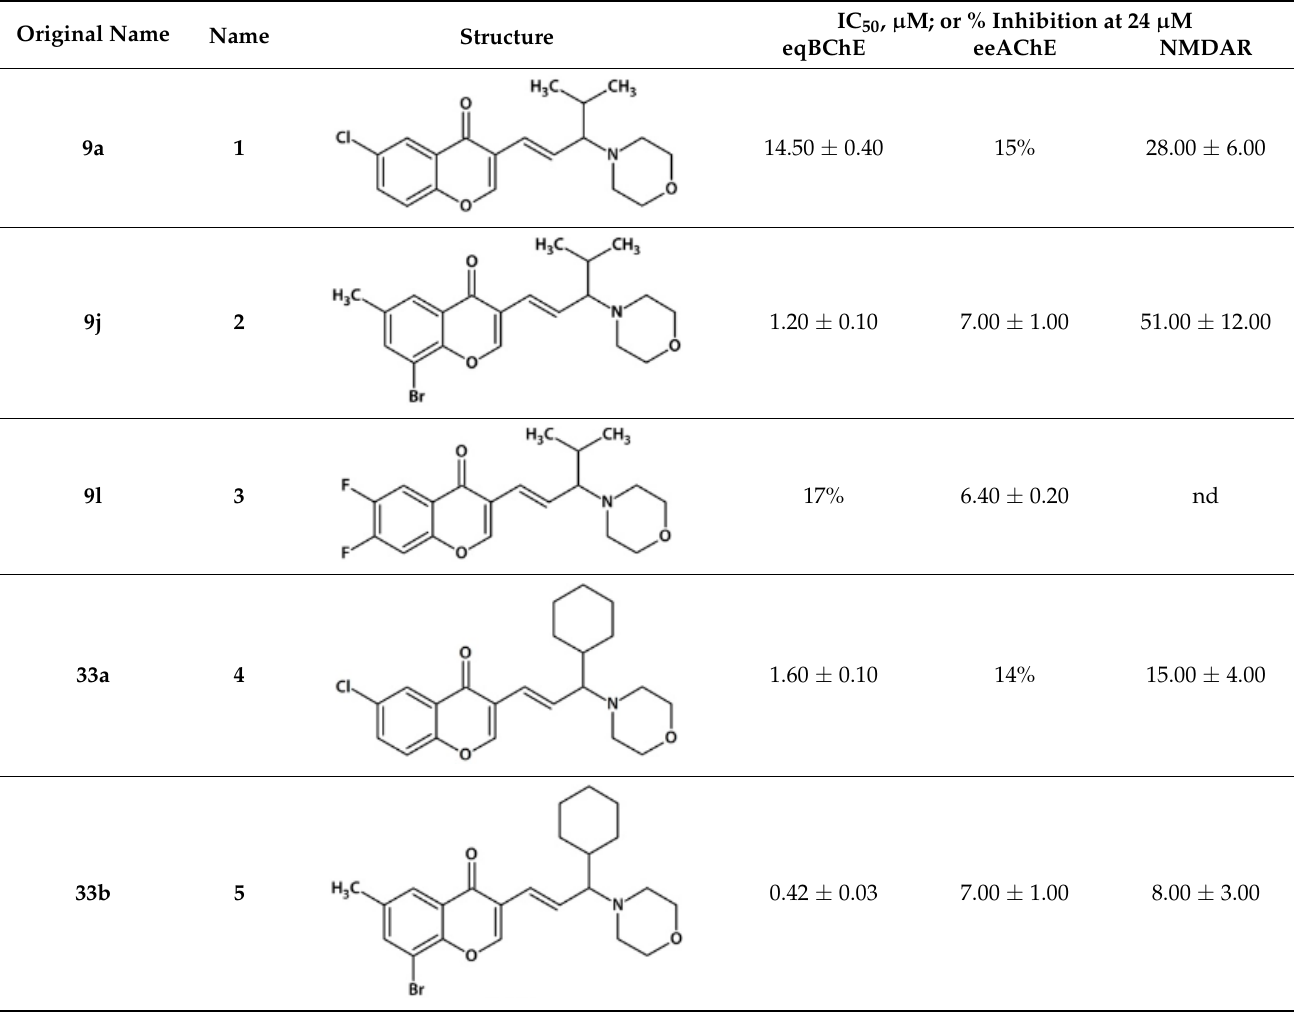
Figure 1. Design of Experiments 1–5 and 8 ( A ) and Experiments 6 and 7 ( B ). CCAM, chromone- containing allylmorpholine; TW, tank water.